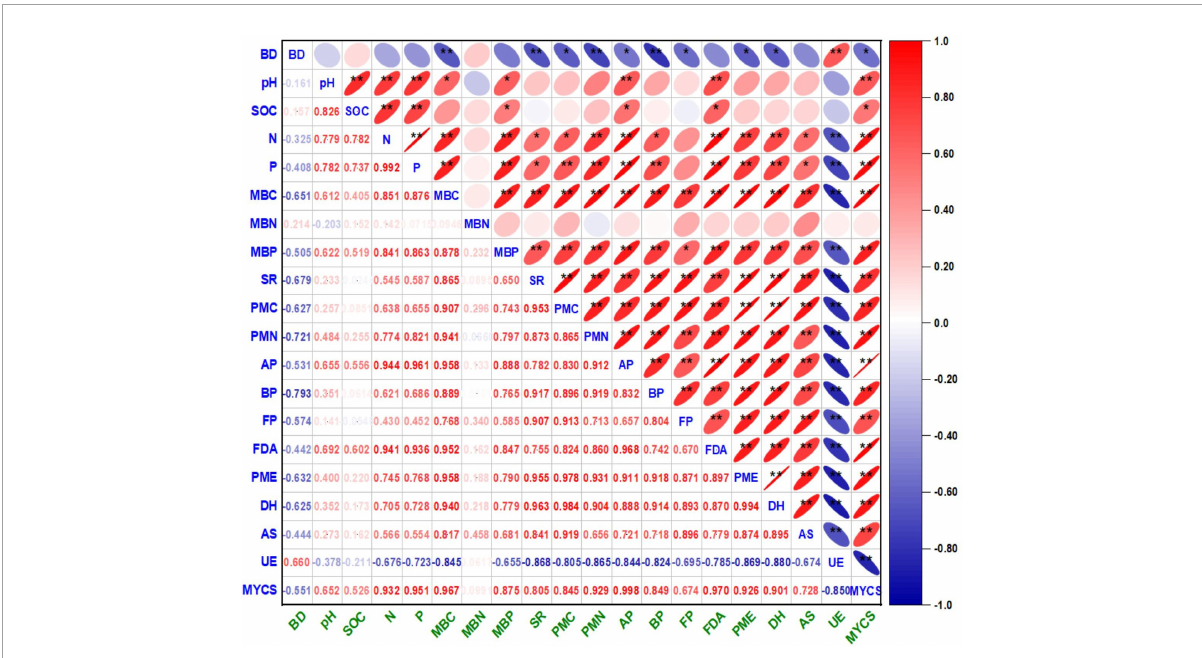
FIGURE3 Correlograms of Pearson correlation coefficients ( r ) matrix between the soil physico-chemical and biological entities under cauliflower–cowpea–okra cropping system. The correlation coefficient ( r ) values are significantly positive at p < 0.01 (**) and p < 0.05 (*) levels of probability (2-tailed); the color assigned to a point in the correlograms grid indicates the strength of a correlation between the soil biological entities, and r values correspond directly to the color codes ranging from red to blue, respectively. Right and left tilted ellipse in the correlograms grid indicate positive and negative correlation, respectively. where, Bd, bulk density; SOC, soil organic carbon; MBC, microbial biomass carbon; MINN, mineralizable nitrogen; AP, actinomycetes population; BP, bacterial population; FP, fungal population; AS, arylsulphatase activity; DHA, dehydrogenase activity; FDA, fluorescein di-acetate hydrolysis activity; PMA, phosphomonoesterase activity; UE, urease